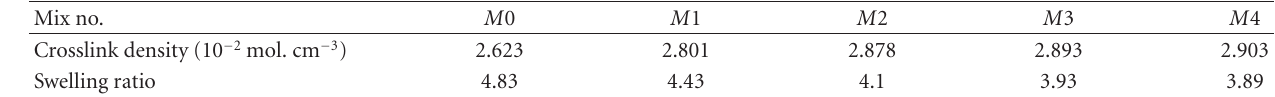
Table 5: Crosslinking density of vulcanized natural rubber.